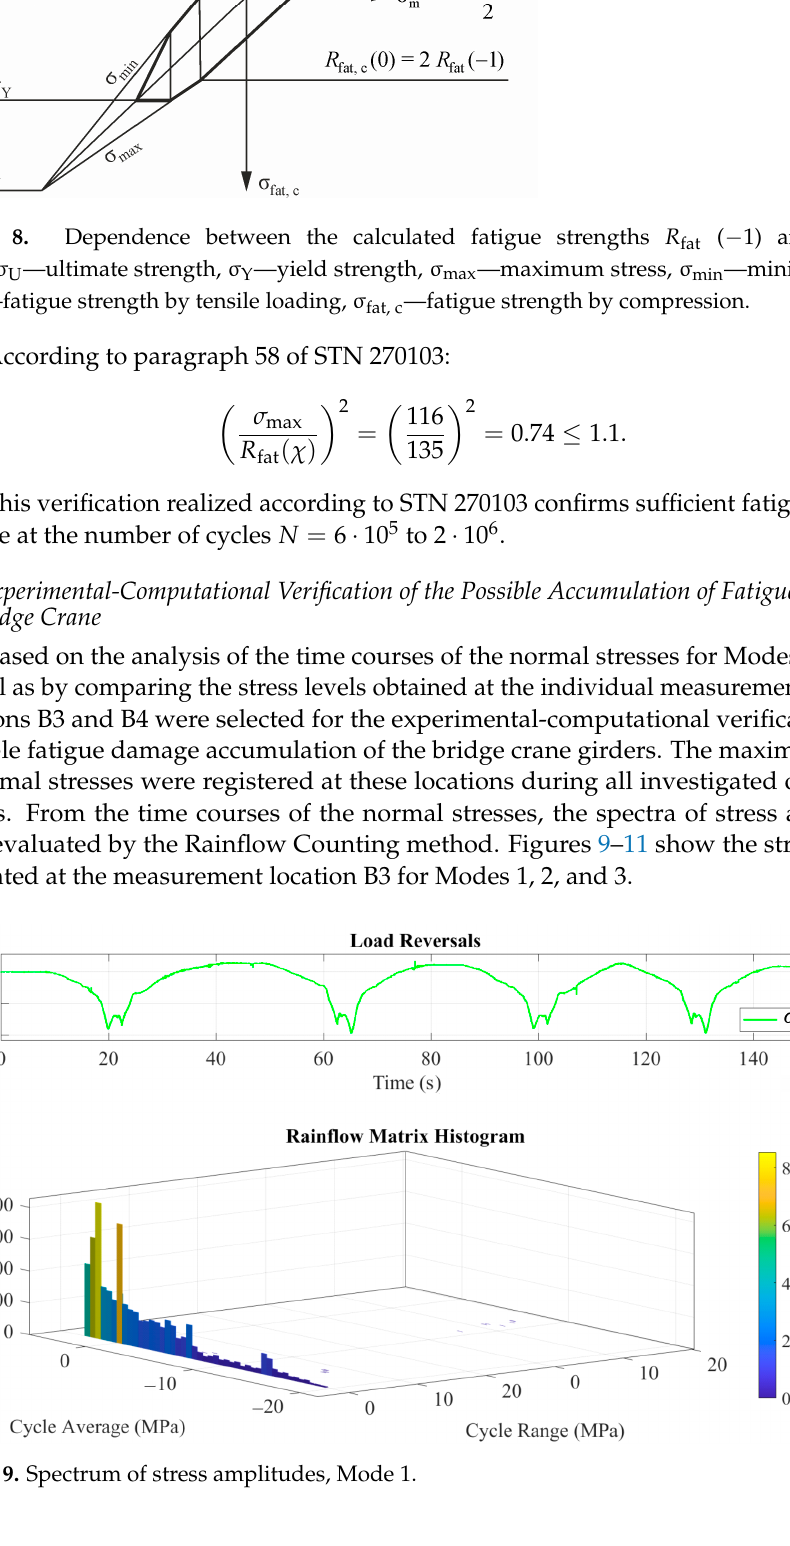
Figure 10. Spectrum of stress amplitudes, Mode 2.